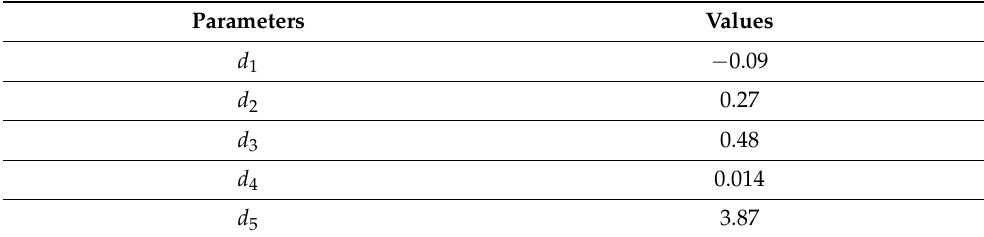
Table 2. J-C shear failure parameters of TC4 titanium alloy